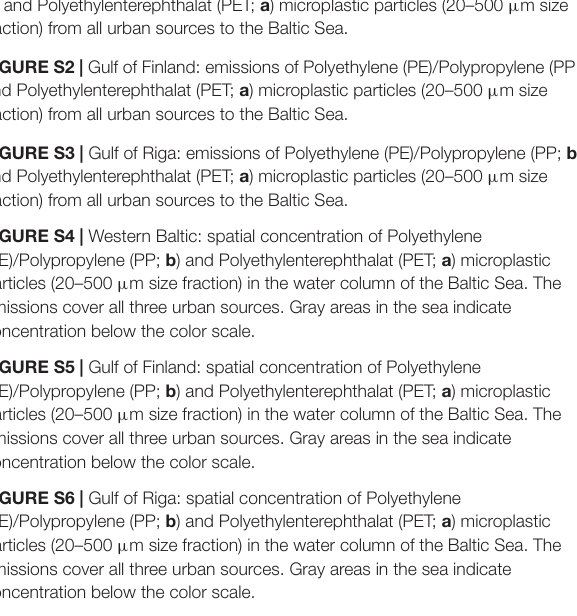
FIGURE S1 | Western Baltic: emissions of Polyethylene (PE)/Polypropylene (PP; b) and Polyethylenterephthalat (PET; a ) microplastic particles (20–500 µ m size fraction) from all urban sources to the Baltic Sea. FIGURE S2 | Gulf of Finland: emissions of Polyethylene (PE)/Polypropylene (PP; b ) and Polyethylenterephthalat (PET; a ) microplastic particles (20–500 µ m size fraction) from all urban sources to the Baltic Sea. FIGURE S3 | Gulf of Riga: emissions of Polyethylene (PE)/Polypropylene (PP; b ) and Polyethylenterephthalat (PET; a ) microplastic particles (20–500 µ m size fraction) from all urban sources to the Baltic Sea. FIGURE S4 | Western Baltic: spatial concentration of Polyethylene (PE)/Polypropylene (PP; b ) and Polyethylenterephthalat (PET; a ) microplastic particles (20–500 µ m size fraction) in the water column of the Baltic Sea. The emissions cover all three urban sources. Gray areas in the sea indicate concentration below the color scale. FIGURE S5 | Gulf of Finland: spatial concentration of Polyethylene (PE)/Polypropylene (PP; b ) and Polyethylenterephthalat (PET; a ) microplastic particles (20–500 µ m size fraction) in the water column of the Baltic Sea. The emissions cover all three urban sources. Gray areas in the sea indicate concentration below the color scale. FIGURE S6 | Gulf of Riga: spatial concentration of Polyethylene (PE)/Polypropylene (PP; b ) and Polyethylenterephthalat (PET; a ) microplastic particles (20–500 µ m size fraction) in the water column of the Baltic Sea. The emissions cover all three urban sources. Gray areas in the sea indicate concentration below the color scale. FIGURE S7 | Spatial concentration of Polyethylenterephthalat (PET) microplastic particles (20–500 mm size fraction) at the sediment surface of the western Baltic Sea (a) , the Gulf of Finland (b) and the Gulf of Riga (c) based on simulations with a 3D hydrodynamic model. PET represents sinking plastic. The emissions cover all three urban sources. Gray areas in the sea indicate concentrations below 0.01 particles/m 2 . FIGURE S8 | Western Baltic: accumulation of Polyethylene (PE)/Polypropylene (PP; b ) and Polyethylenterephthalat (PET; a ) microplasticparticles (20–500 µ m size fraction) at shores based on simulations with a 3D hydrodynamic model. PE/PP represents floating and PET sinking plastic. The emissions cover all three urban sources. FIGURE S9 | Gulf of Finland: accumulation of Polyethylene (PE)/Polypropylene (PP; b ) and Polyethylenterephthalat (PET; a ) microplastic particles (20–500 µ m size fraction) at shores based on simulations with a 3D hydrodynamic model. PE/PP represents floating and PET sinking plastic. The emissions cover all three urban sources. FIGURE S10 | Western Baltic: accumulation of Polyethylene (PE)/Polypropylene (PP; b ) and Polyethylenterephthalat (PET; a ) microplastic particles (20–500 µ m size fraction) at shores based on simulations with a 3D hydrodynamic model. PE/PP represents floating and PET sinking plastic. The emissions cover all three urban sources. FIGURE S11 | (a) Sinking velocities and critical shear stress: Both sinking velocities and critical shear stresses for microplastics particles depend on viscosity, therefore they vary with temperature. The example shows values for 10 ◦ C water temperature. (b) Vertical profiles of MP distribution: The following image shows mean vertical profiles (March 2016–February 2017) for two different types of microplastics for station HELCOM121 (Gulf of Riga, 23.617 ◦ E, 57.6167 ◦ N) as an